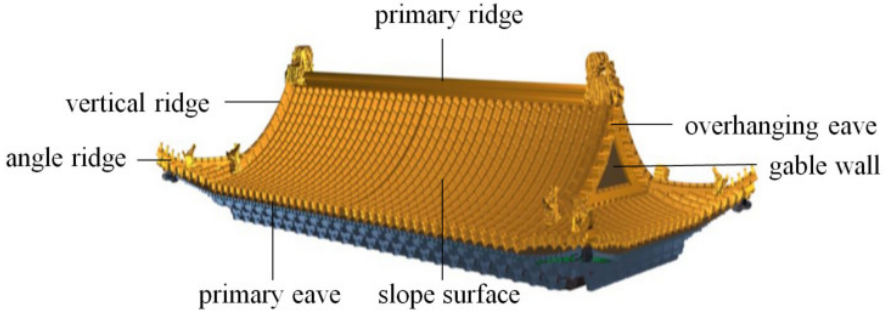
Figure 3. Structural semantic